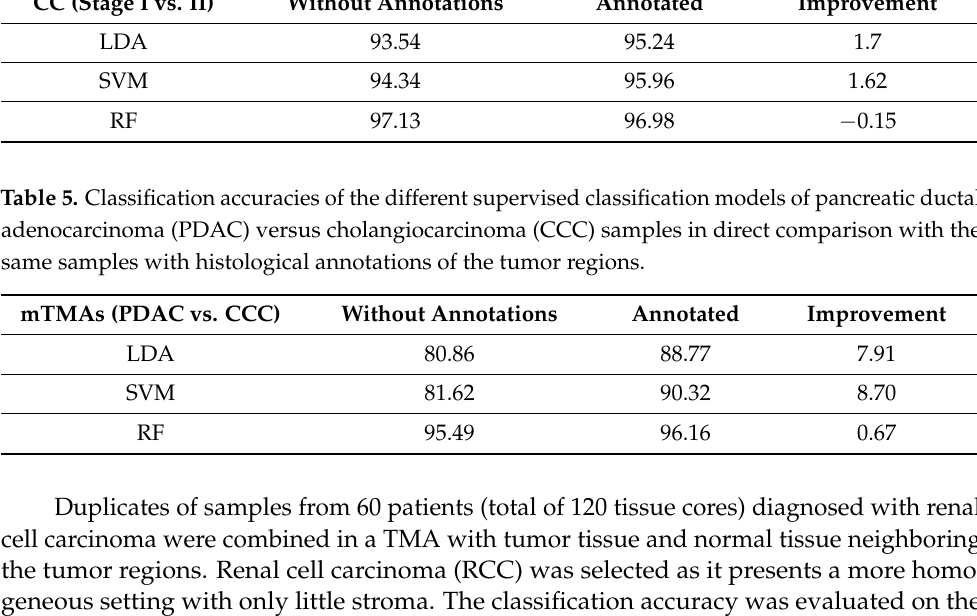
Table 4. Classification accuracies of the different supervised classification models using samples from stage I and II colon cancer (CC) with and without histological annotation of the epithelial regions. CC (Stage I vs. II)